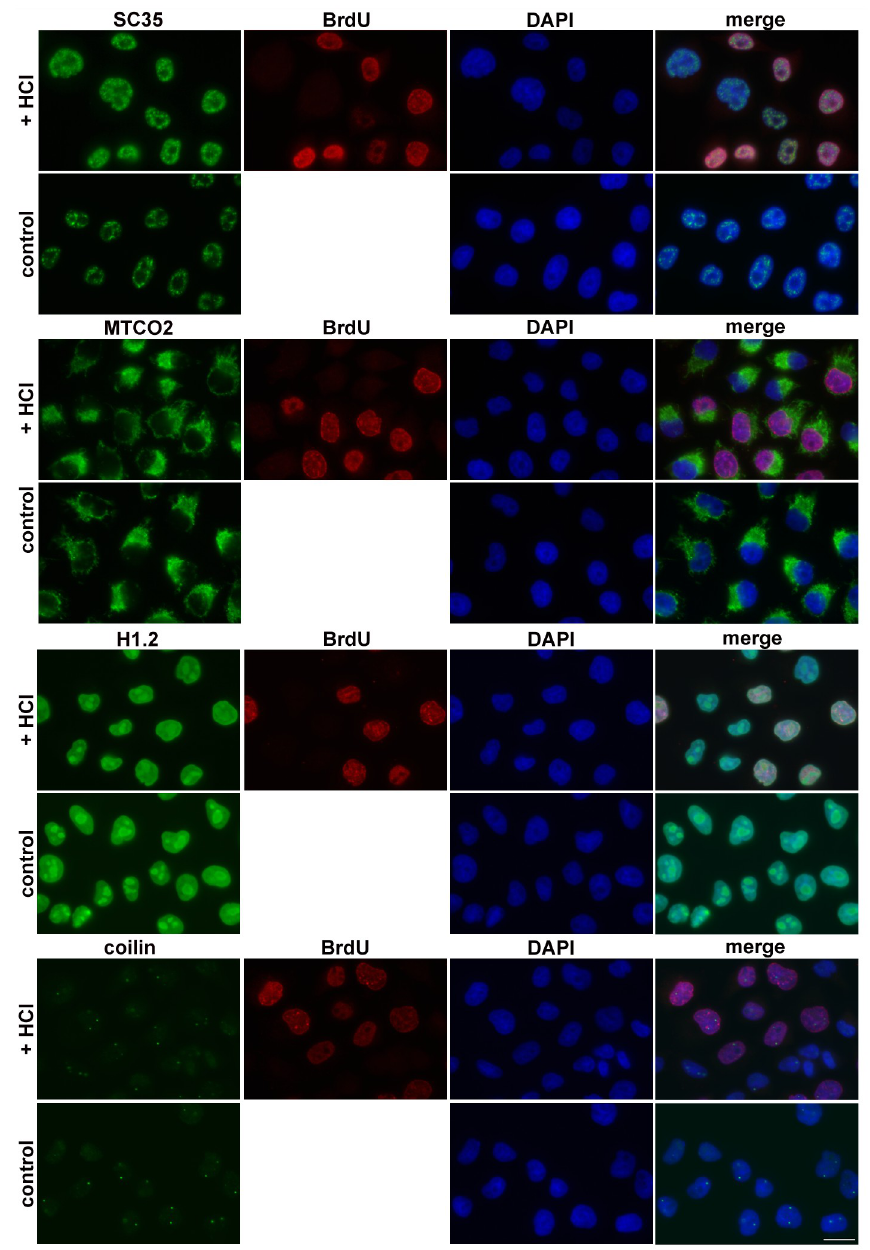
Fig 2. The effect of optimized procedure on the localisation of cellular proteins. HeLa cells were incubatedwith BrdU for 30 minutes and fixed with formaldehyde. BrdU was revealedusing 20 mM HCl. The proteinsSC35, mitochondrial protein MTCO2, histone H1.2 and coilin were concurrentlydetected with the incorporated BrdU. BrdU was detected using either chicken polyclonal antibody or B44 monoclonal antibody dependingon the host producing the antibody for the particularcellularprotein. The control cells were not labelledwith BrdU and were not treated with HCl and exonuclease III. Proteins are in green, BrdU is in red and DAPI is in blue. Scale bar = 20 μ